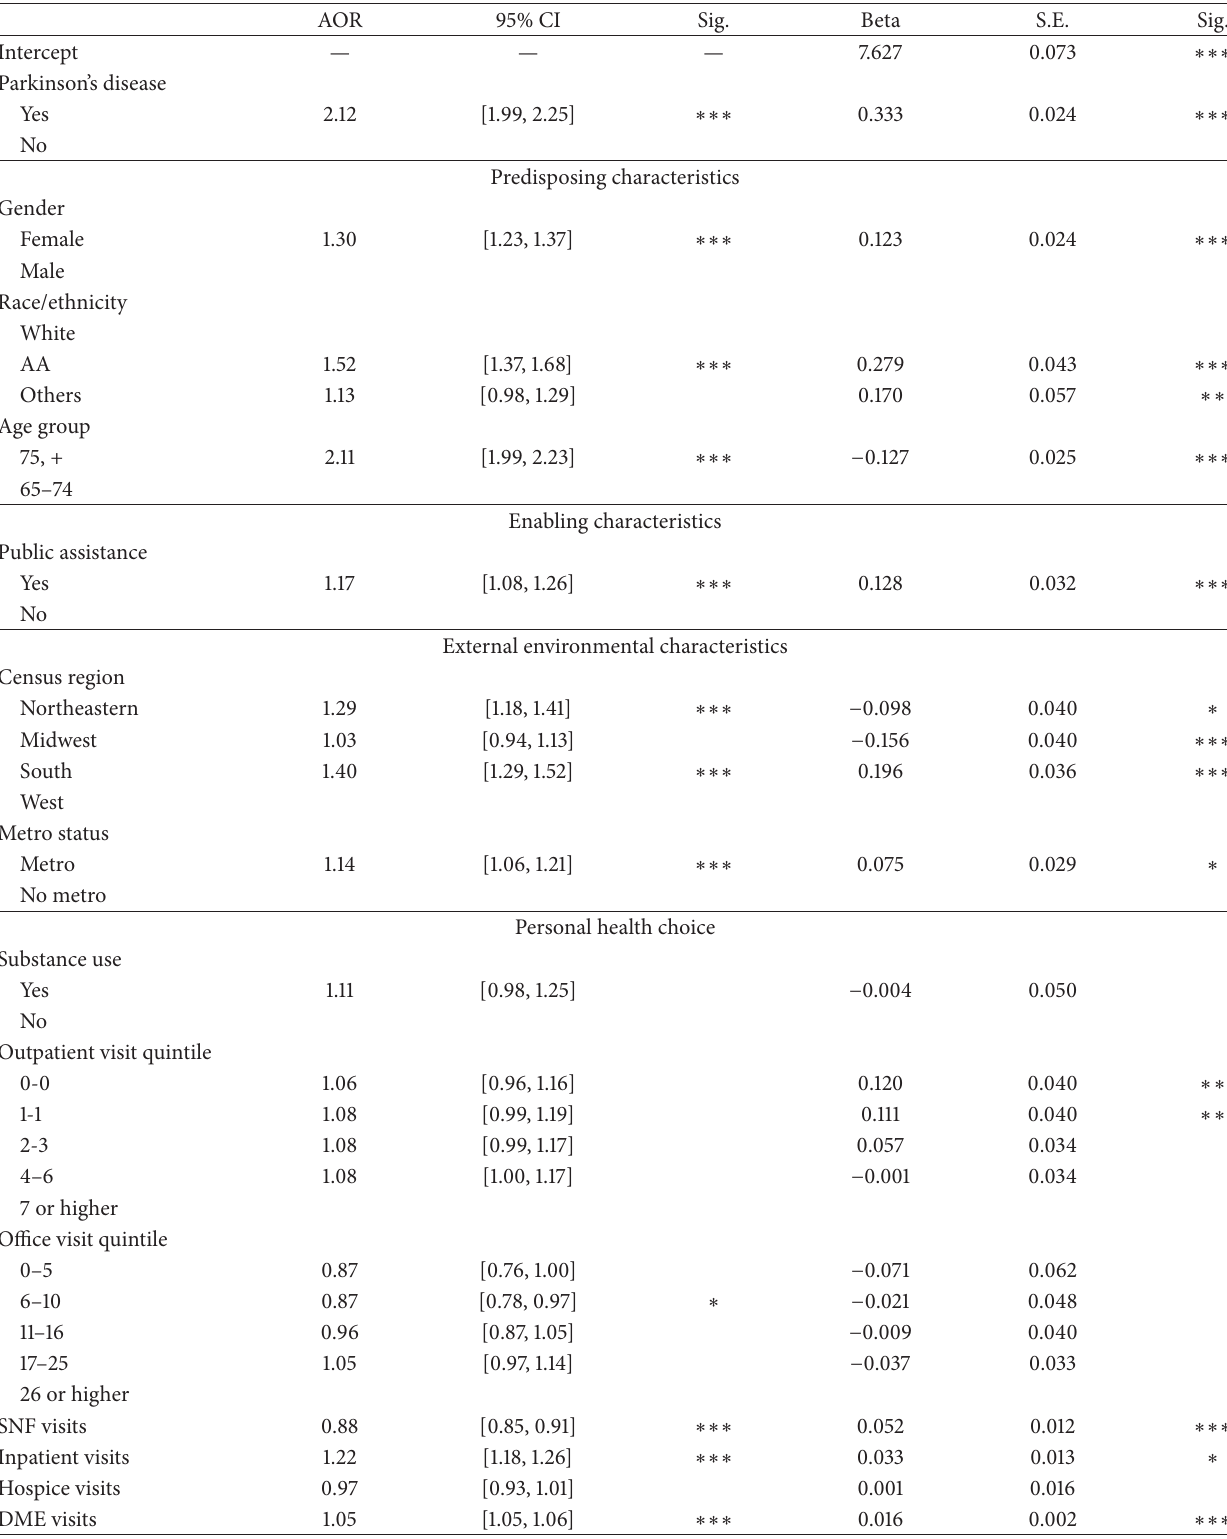
Table 3: Adjusted Odds Ratios and 95% Confidence Intervals from logistic regression on home healthcare use and parameter estimates